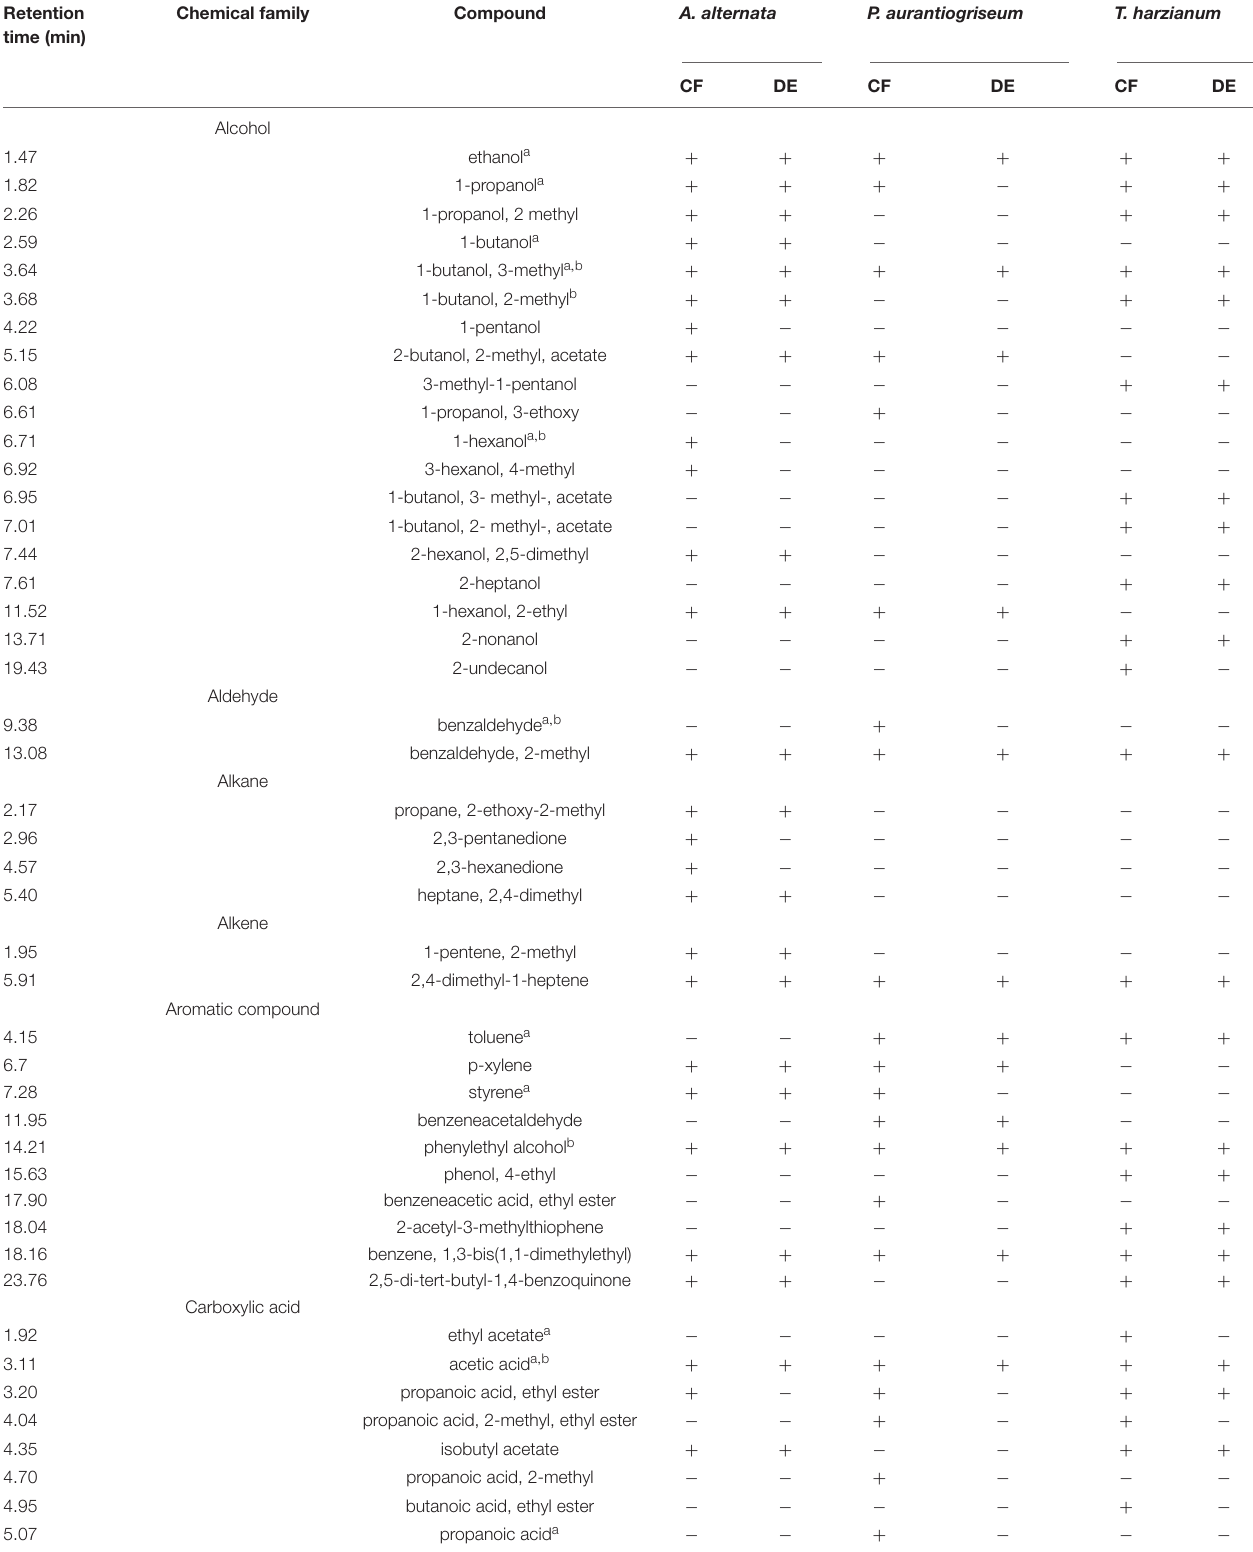
TABLE 5 | Headspace analysis (SPME/GC-MS) of VOCs collected from filtrates and DEs obtained from A. alternata, P. aurantiogriseum , and T. harzianum liquid cultures. Retention time